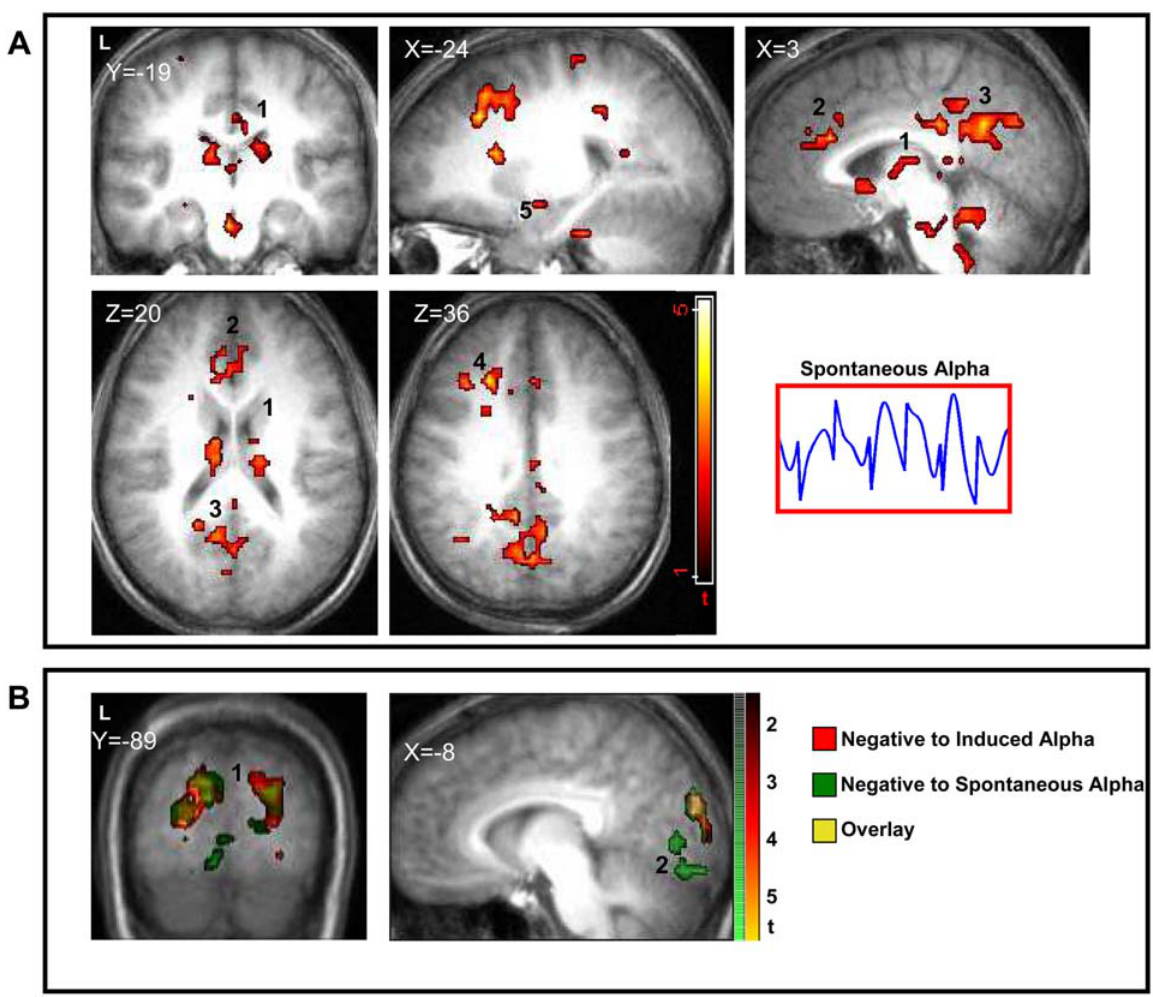
Figure 4. Spontaneous and negative alpha BOLD activation maps. A. Spontaneous alpha BOLD activation maps: Different slice views of BOLD activation group maps (n=10 random effect, p , 0.02 uncorrected, min 15 voxels) obtained by individual regressors of the spontaneous alpha component. Areas of activation are denoted by numbers: Dorso Medial Thalamus (1), Medial Prefrontal Cortex (2), Retrosplenial Cortex (3), Dorso Lateral Prefrontal Cortex (4), Amygdala (5). B. Negative alpha BOLD activation maps: Different slice views of BOLD activation group maps (n=10 random effect, p , 0.02 uncorrected, min 15 voxels) obtained by negative correlation to individual regressors of induced and spontaneous alpha components (red and green respectively). As expected negative correlation in both networks reveal predominantly visual areas. Areas of activation are denoted by numbers: primary Visual Cortex (1), high order visual areas (2).